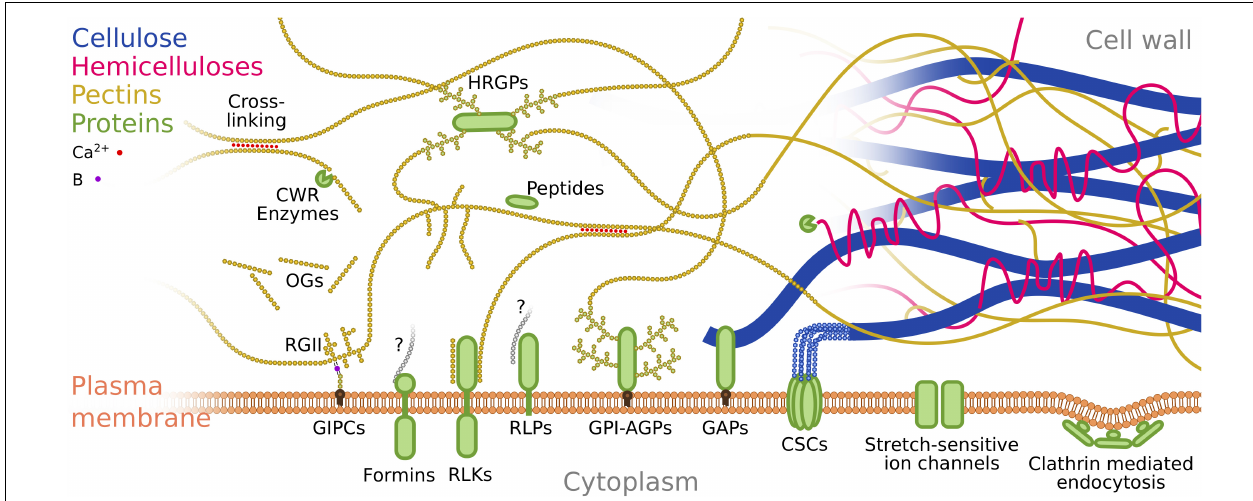
FIGURE 2 | Putative mechanosensing structures at the cell wall and plasma membrane. Schematic representation of the various structures potentially involved in plant mechanosensing, and their interactions. For clarity and ease of representation we focus on some of the interactions between pectins, proteins and plasma membrane (and focus less on cellulose and hemicelluloses). Cellulose is represented in blue, hemicelluloses in magenta, pectins in yellow, proteins in green and plasma membrane in orange. Red dots represent calcium ions involved in pectin cross linking. The purple dot represents boron involved in RGII-GIPC cross-linking. Gray polysaccharides labeled with a question mark in the case of Formins and RLPs accounts for interaction of these proteins with the cell wall with the nature of the polysaccharide or molecule involved remaining unknown. Ca 2 + , Calcium; B, Boron; CWR, Cell Wall Remodeling; HRGP, Hydroxyproline-rich Glycoproteins; OGs, OligoGalacturonans; RGII, RhamnoGalacturonanII; GIPCs, Glycosyl Inositol Phospho Ceramides; RLKs, Receptor-Like Kinases; RLPs, Receptor-Like Proteins; GPI-AGPs, GlycosylPhosphatidylInositol anchored ArabinoGalactan Proteins; GAPs, GlycosylPhosphatidylInositol Anchored Proteins; CSCs, Cellulose Synthase